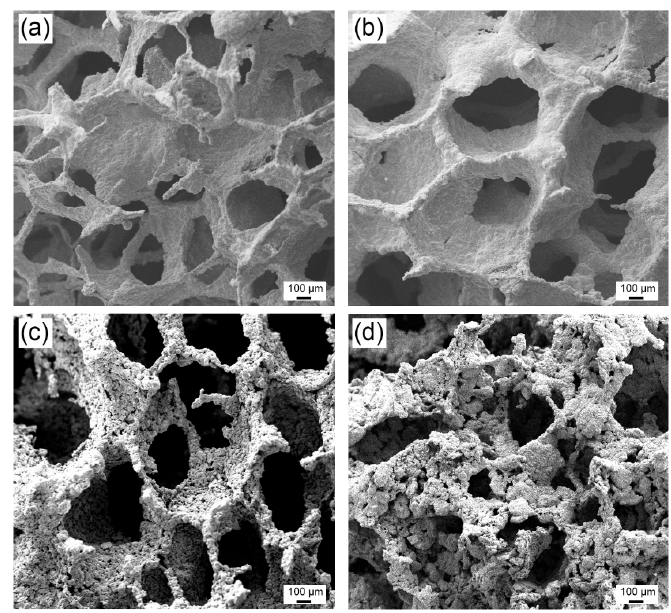
Figure 1. ( a ) SEM image of a Fe-O foam prepared at a nitrogen flow rate of 180 L/min. SEM image of Fe-Mn-O foams prepared under a nitrogen flow rate of ( b ) 180 L/h, ( c ) 350 L/h and ( d ) 650 L/h.